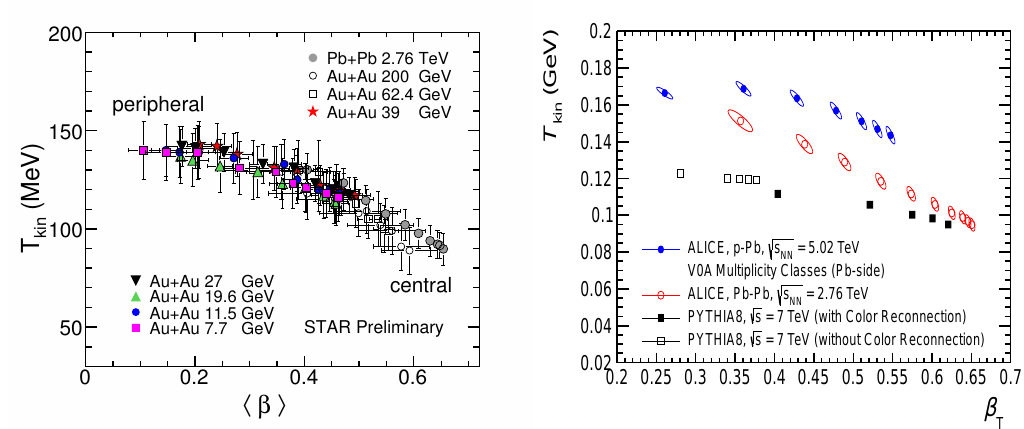
Figure 10. Left : Variation of the blast wave parameters T kin and (cid:104) β (cid:105) obtained from the fits to the spectra of pions, kaons, protons, and their anti-particles produced in Au + Au and Pb + Pb collisions √ s at energies = 7.7 GeV − 2.76 TeV and different collision centralities. The centrality increases NN from left to right for a given energy. Reproduced from Ref. [199]; Right : The same, but for Pb + Pb √ √ s s at = 2.76 TeV and p + Pb at = 5.02 TeV. MC simulations of p + p collisions at NN NN using the PYTHIA8 event generator [200] with and without color reconnection are shown as open and filled squares, respectively. Reproduced from Ref.